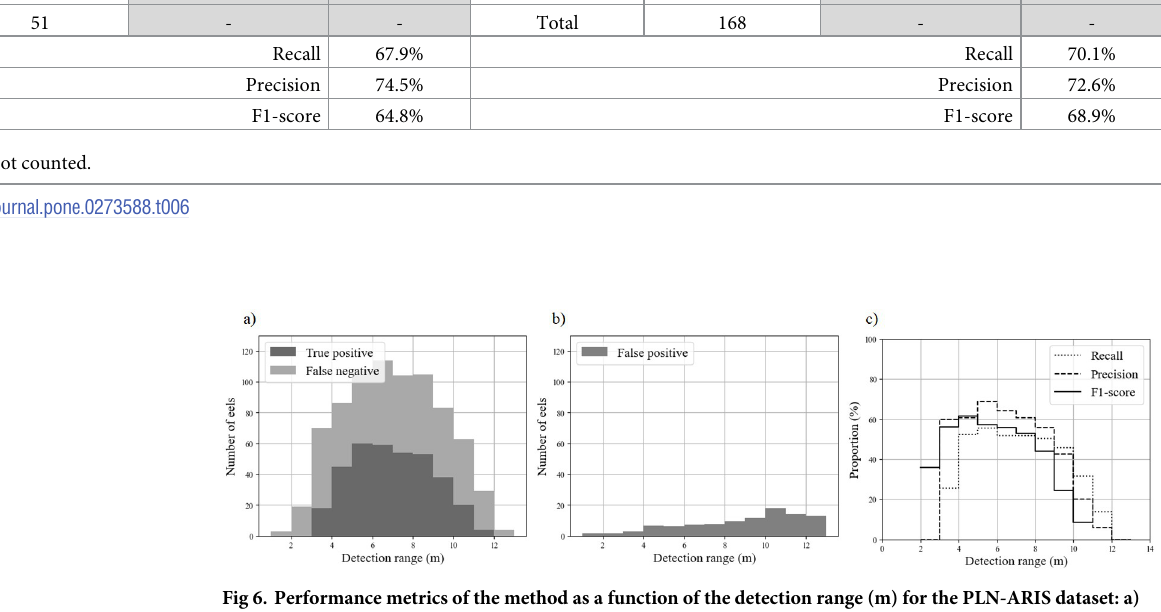
Table 6. Confusion matrices and performance metrics obtained for a common 73-hour period at Mauzac recorded by ARIS and BlueView cameras. ARIS Pred. Eels Pred. Others